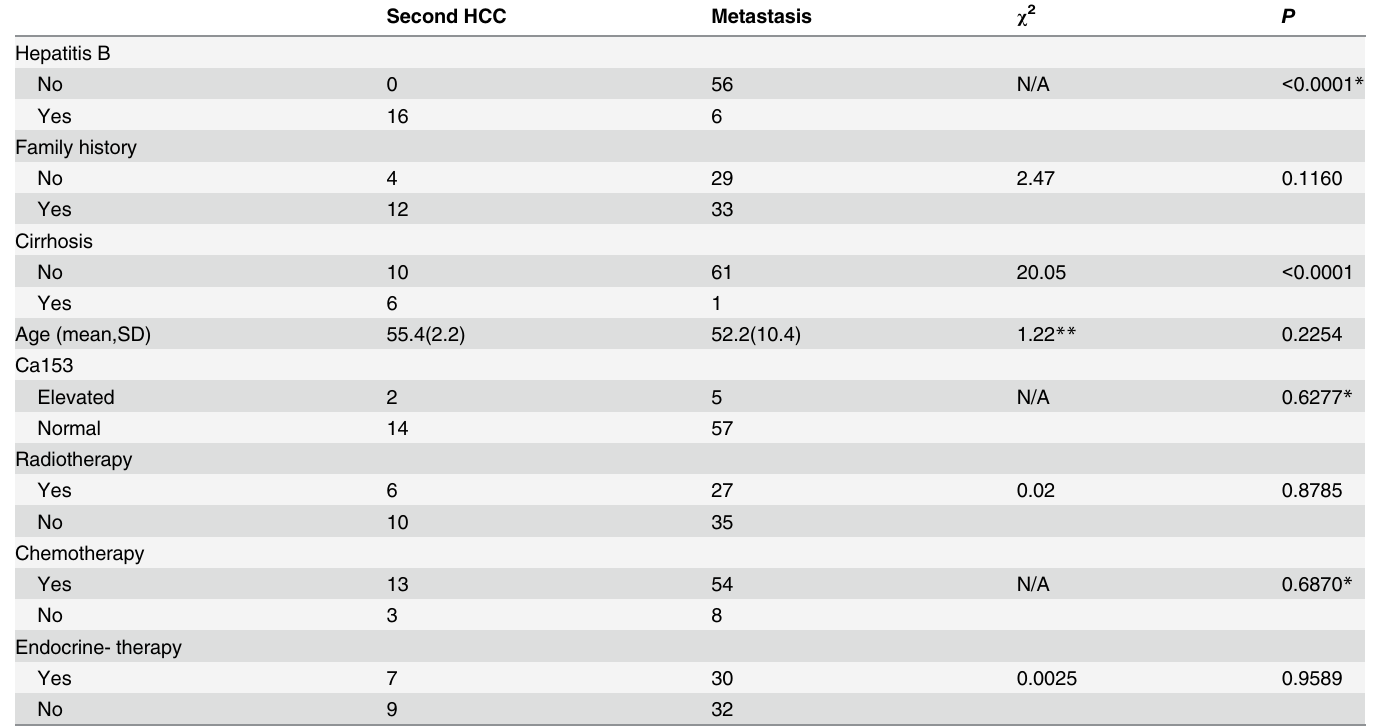
Table 3. Comparison of HBV status, cirrhosis, family history and age between the two